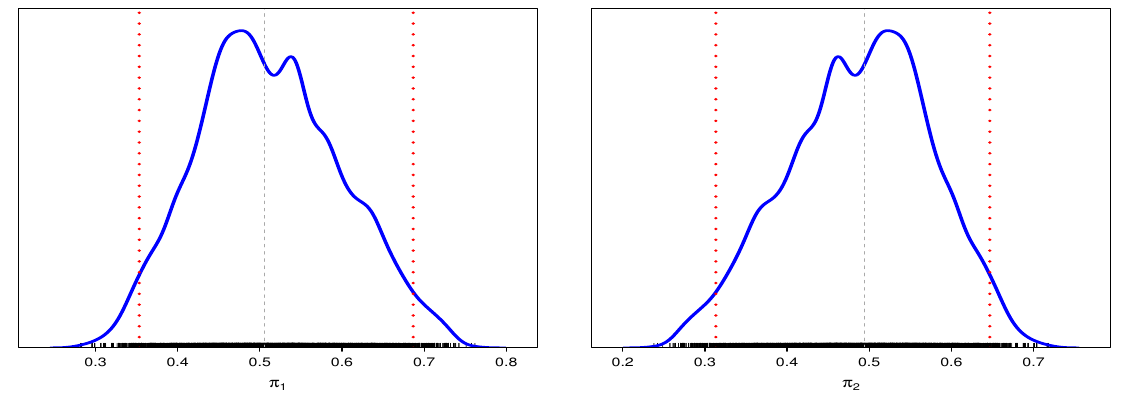
Figure 7. Trace for relative risks of MCMC results.